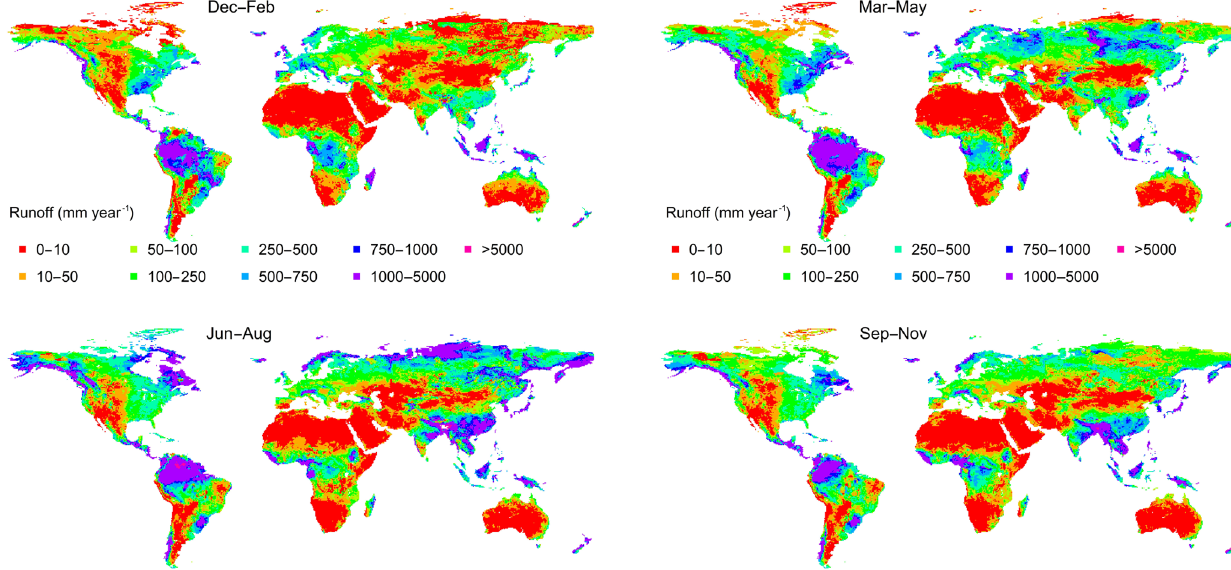
Figure 10. Mean seasonal runoff calculated for the period